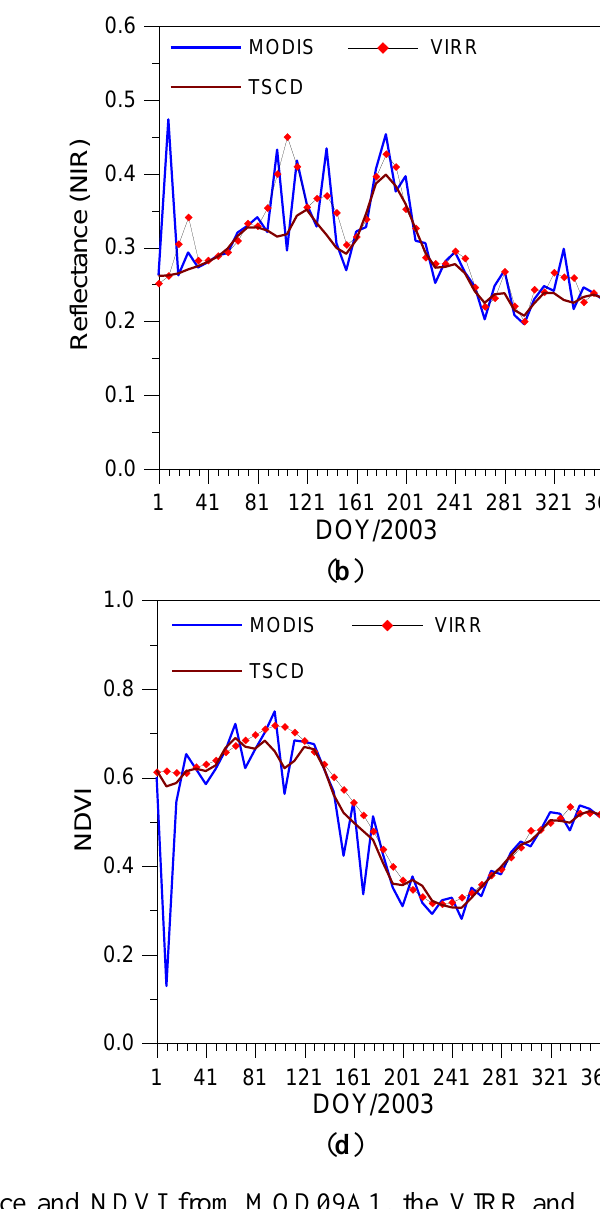
Figure 6. Time series of surface reflectance and NDVI from MOD09A1, the VIRR and TSCD algorithms for the center pixel of the Alpilles site in 2003. ( a ) surface reflectance in the red band; ( b ) surface reflectance in the NIR band; ( c ) surface reflectance in the SWIR band; ( d )